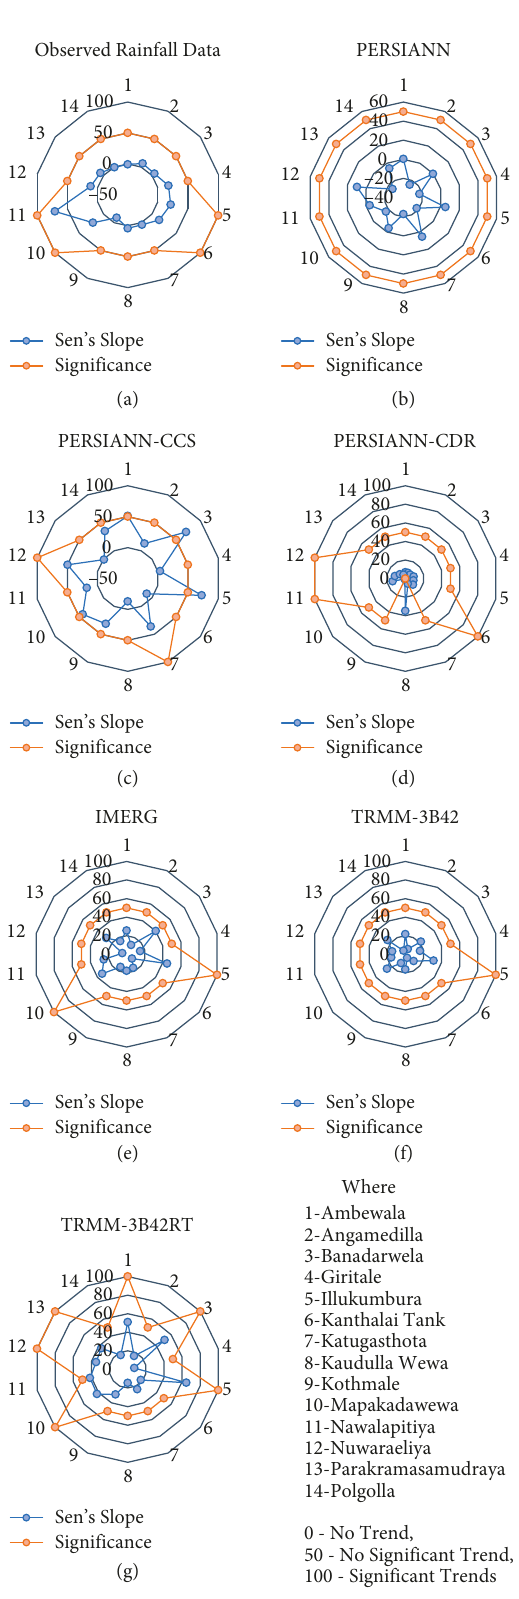
Figure 10: Results obtained from the RB index. (a) For Daily. (b) For